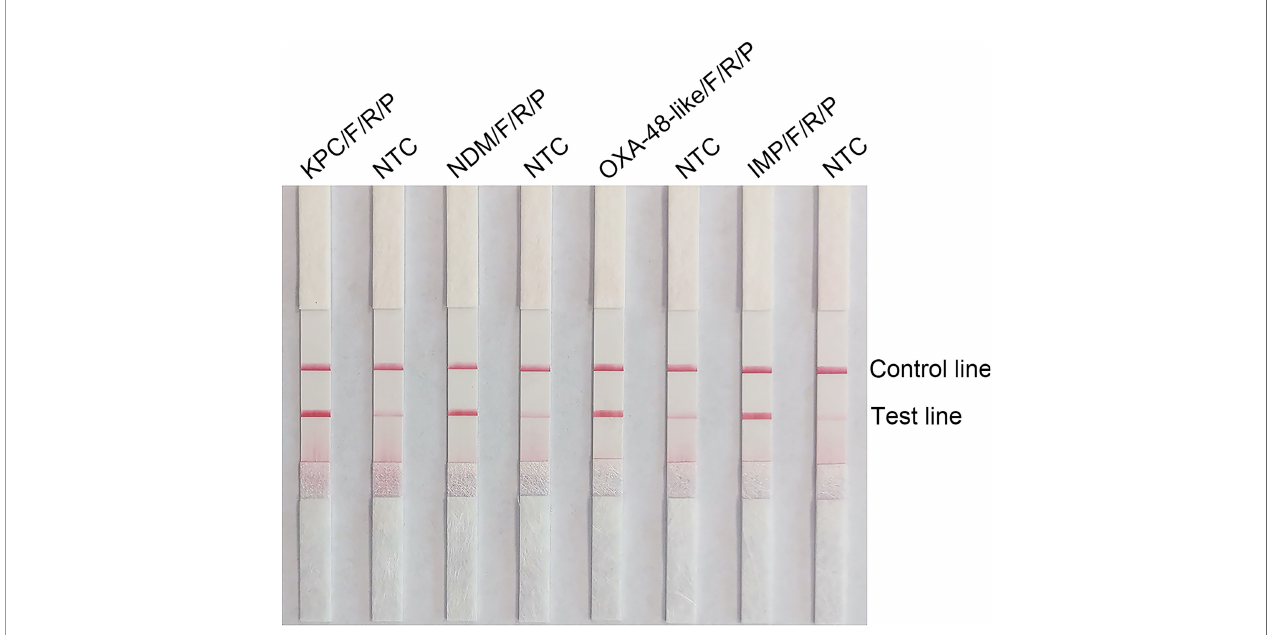
FIGURE 2 | Testing the performance of the primer-probe sets using the RPA-LFS reaction. Results of the LFS detection of the RPA ampli fi cation products are shown. The name of each primer-probe set is labeled above the corresponding strip. The NTC strip is the template-free control for the corresponding RPA reaction on the immediate left strip. The positions of the test and control lines are marked to the right of the bars. The image represents the results of three independent experiments.